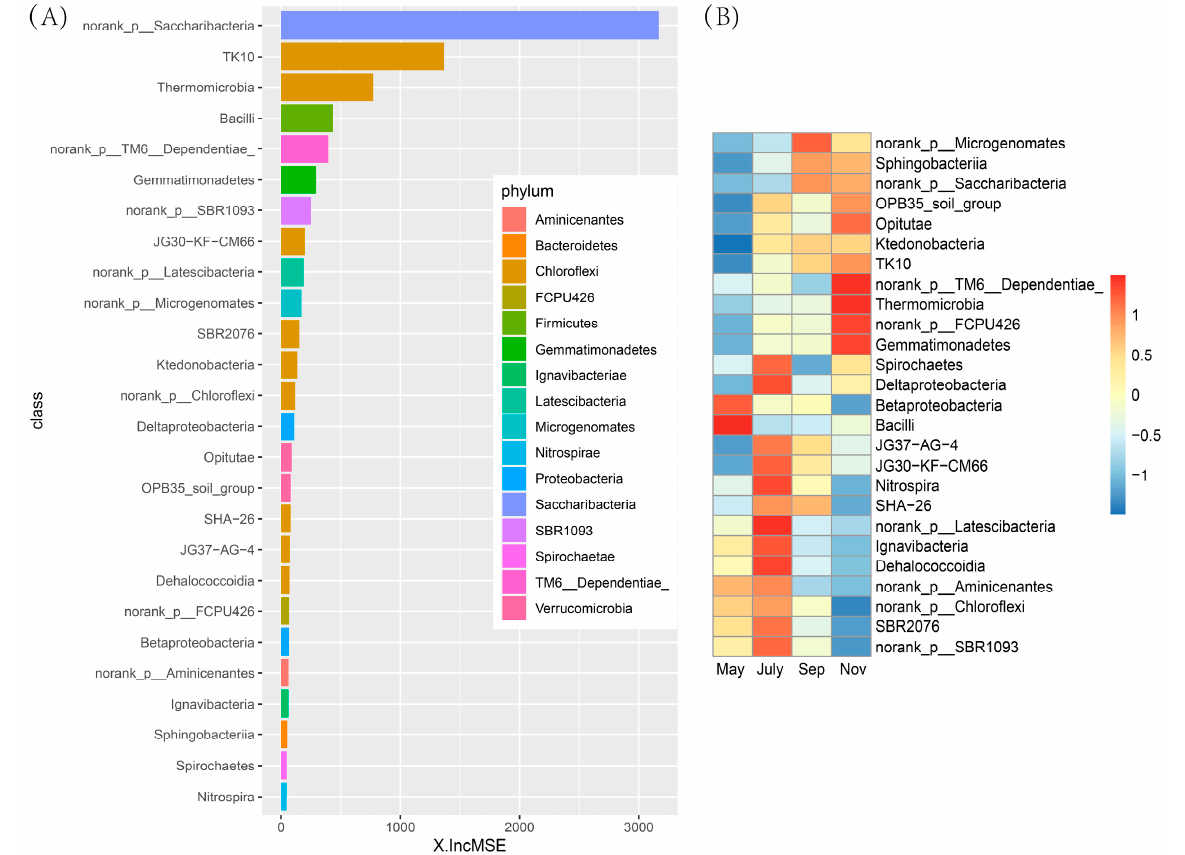
Figure 8. Bacterial taxonomic biomarkers of sugarcane in different stages in fields. ( A ) The top 26 biomarker bacterial classes were identified by applying Random Forests regression of their relative abundances. Biomarker taxa are ranked in descending order of importance to the accuracy of the model, the abscissa represents the weight calculation of each bacterial category indicator. ( B ) Heatmap showing the relative abundances of the top 26 biomarker bacterial classes in the rhizosphere soil of sugarcane.